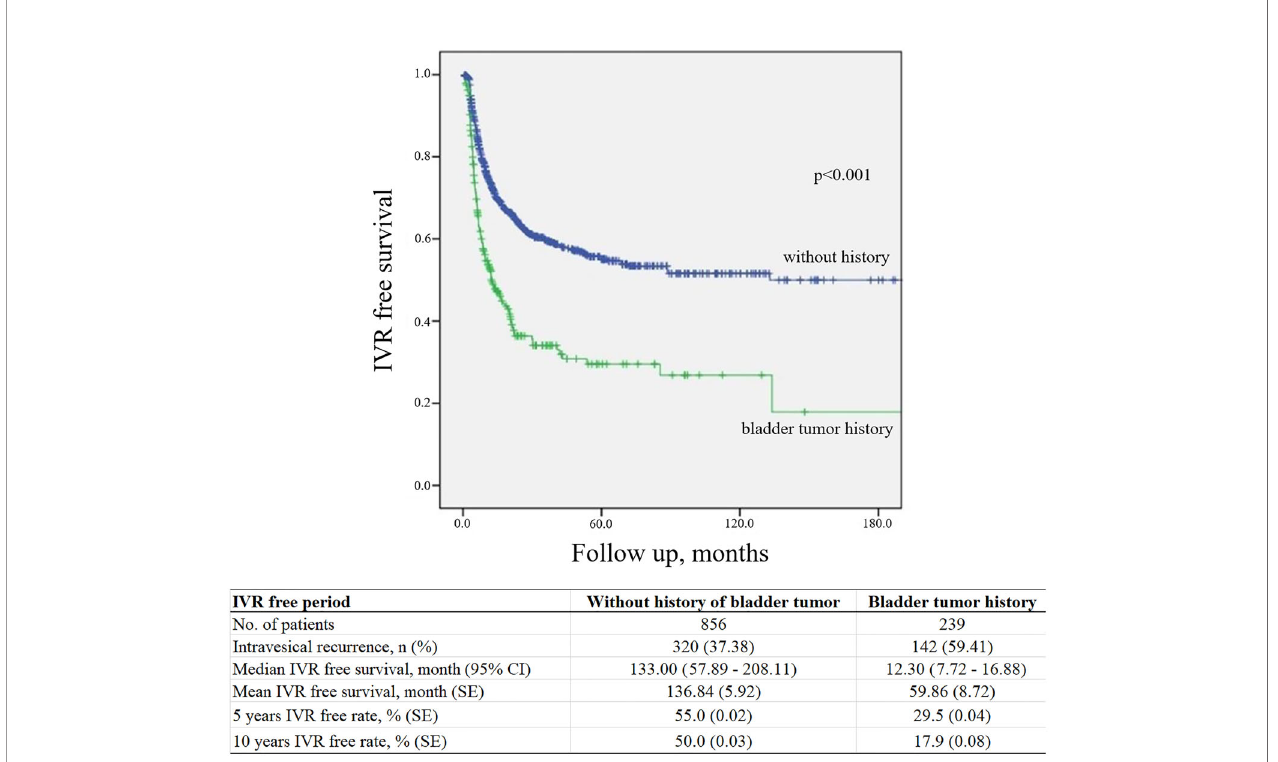
FIGURE 1 | Kaplan – Meier curve for intravesical tumor recurrence according to a history of bladder cancer. IVR, intravesical recurrence; CI, con fi dence interval; SE, standard